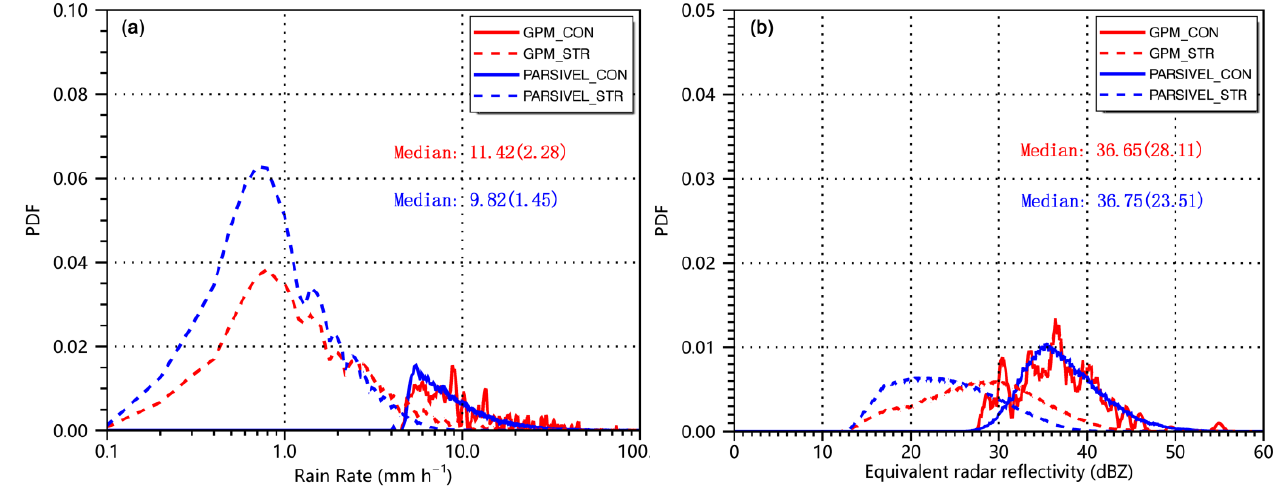
Figure 9. Statistical comparison of PARSIVEL disdrometers and near-surface GPM DPR measure- ments in terms of probability distribution functions (PDFs) for ( a ) rain rate (mm h − 1 ), and ( b ) equivalent radar reflectivity (dBZ). Convective rain (solid lines) and stratiform rain (dashed lines) are compared separately. GPM observations are shown in red lines while PARSIVEL observations are shown in blue lines. The median values of convective samples (outside bracket) and stratiform samples (inside bracket) are also shown in each panel. Table 3. Comparison results of GPM and Parsivel observations for both rain rate and radar reflectivity in Typhoon In-Fa. NB (%) stands for normalized bias adapted from Wu et al. [12]. Rain Type GPM PARSIVEL Sample NB (%) of Radar Rain Type Sample Quantity